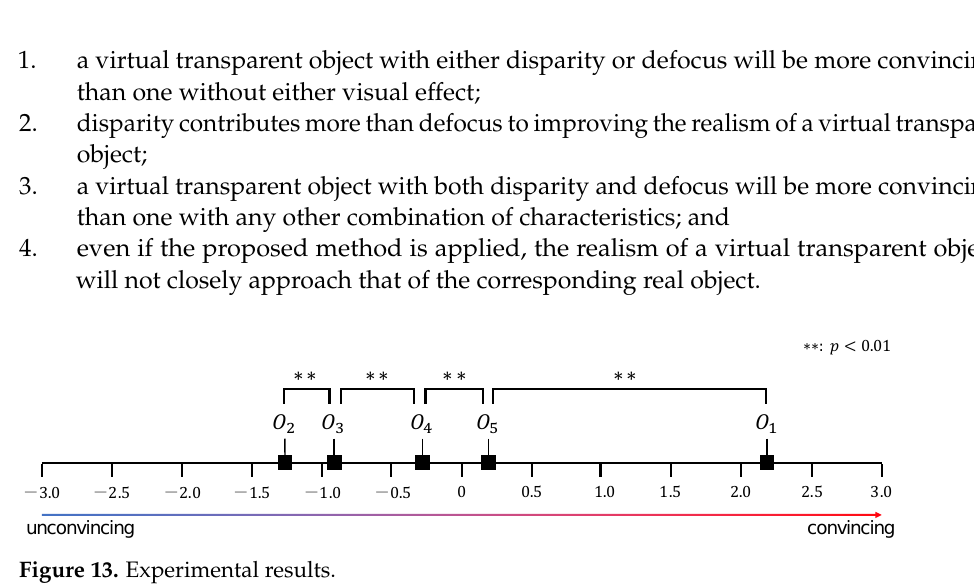
Figure 13. Experimental